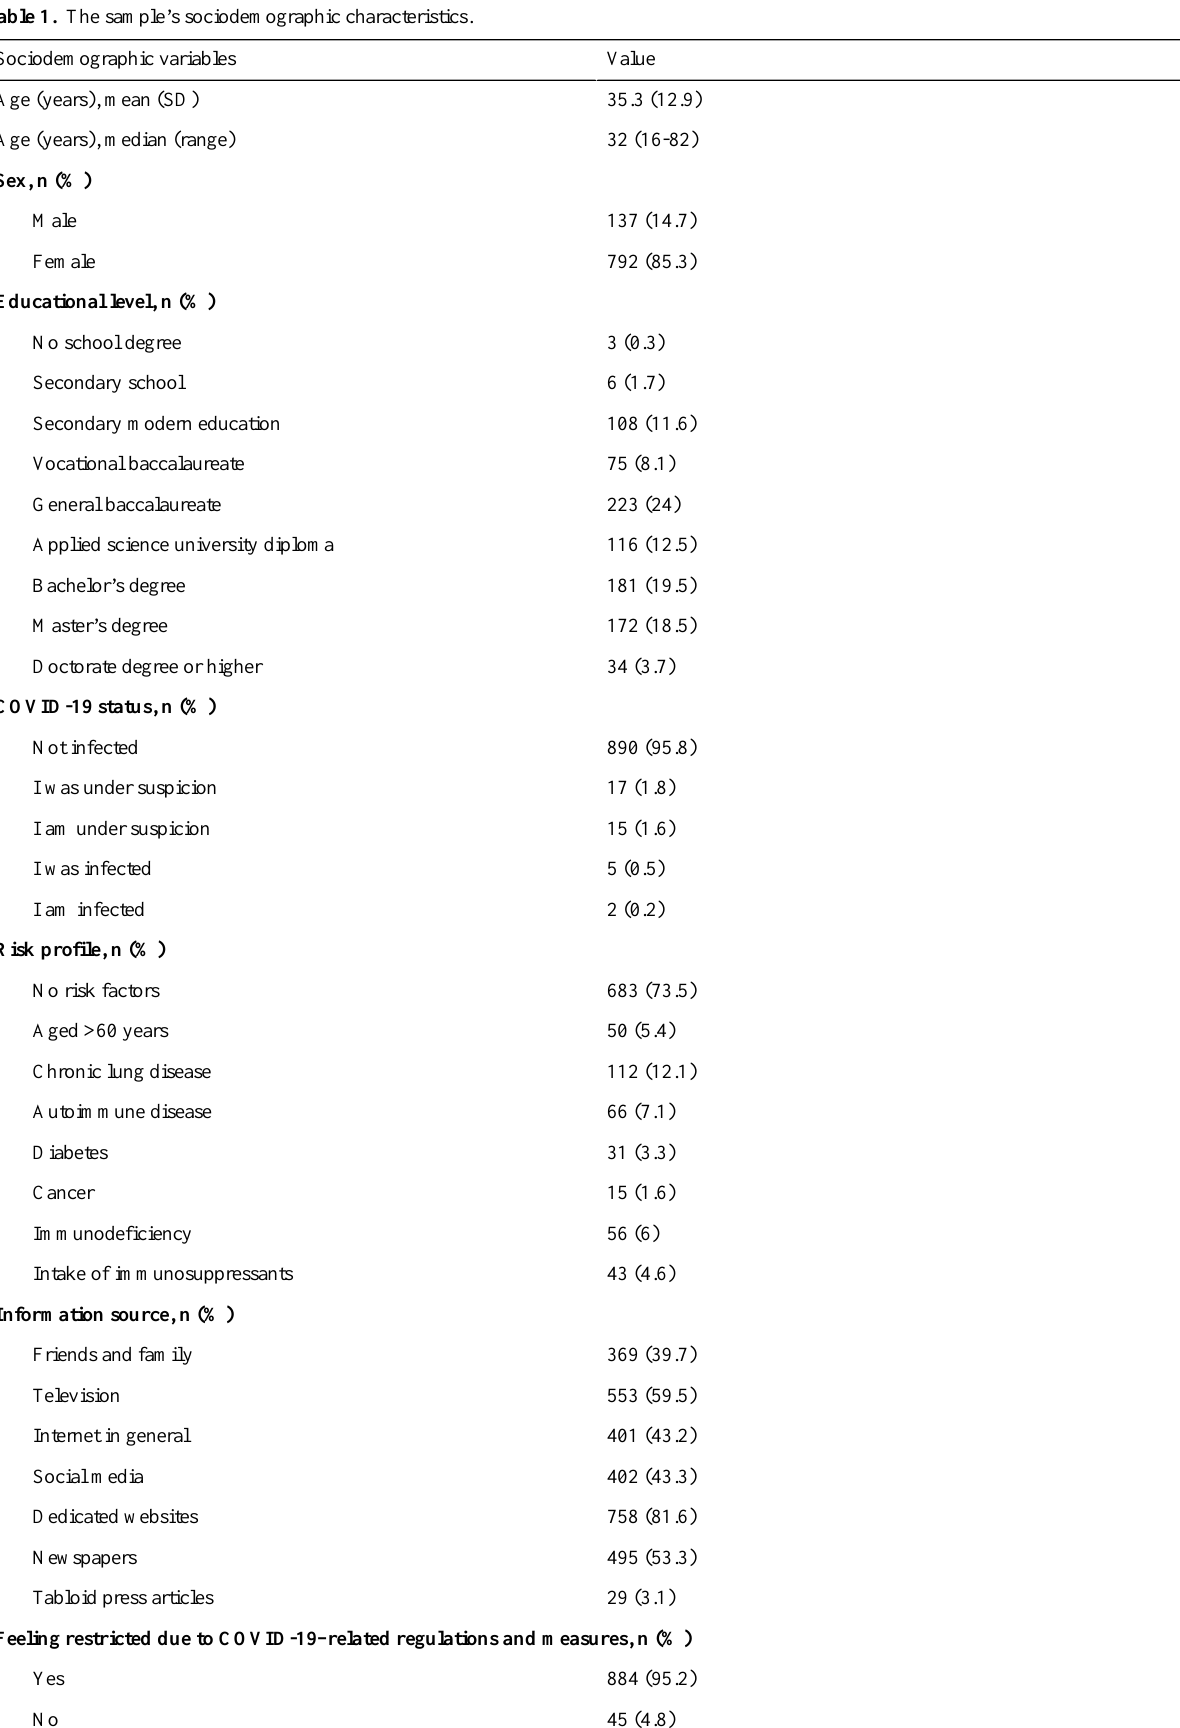
Table 1. The sample’s sociodemographic